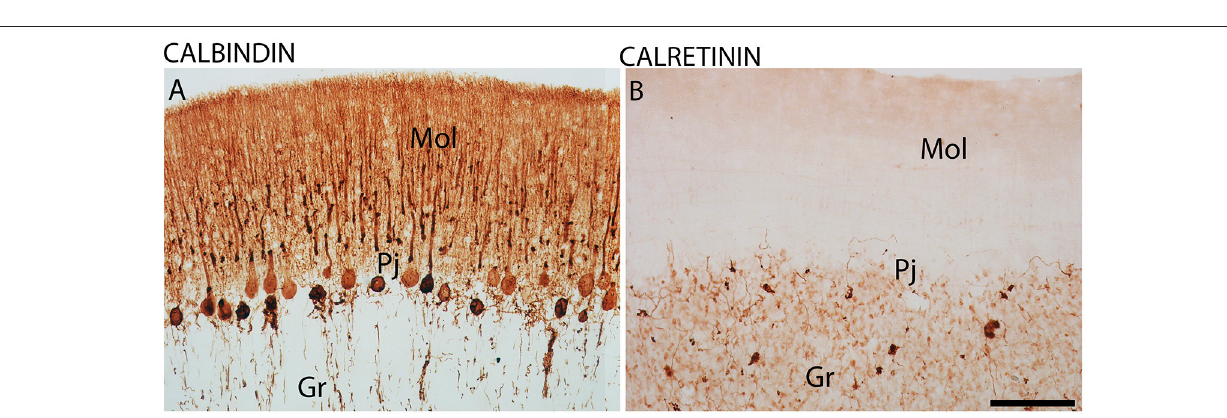
FIGURE 6 | The distribution of calbindin (CB) and calretinin (CR) proteins in the cerebellar cortex in the primate Sapajus apella . Photomicrographs of frontal brain sections show strongly stained CB-IR cells in the Purkinje cell layer (Pj) (A) and CR-IR with significant expression in the granular layer (Gr) (B) . Bar = 100 µ m. Molecular layer